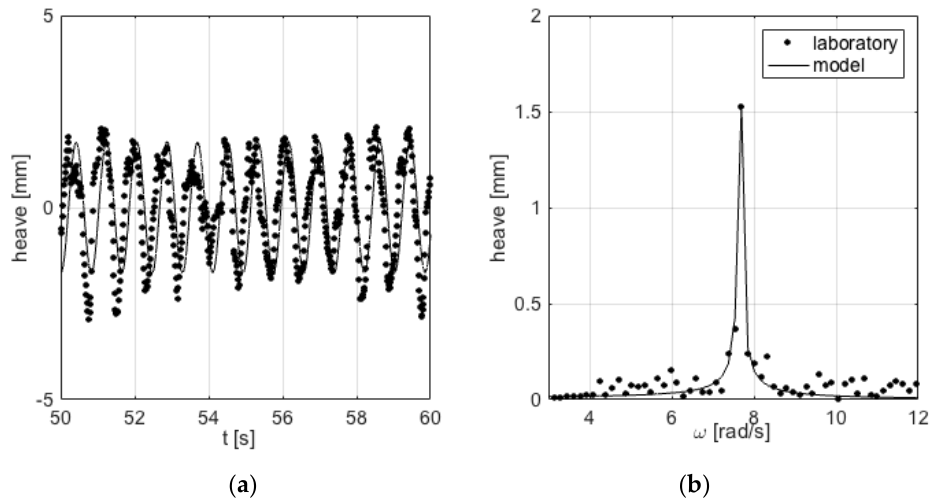
Figure 8. Heave response during test R05: comparison between laboratory and model results of the time series of oscillation ( a ) and spectrum ( b ).